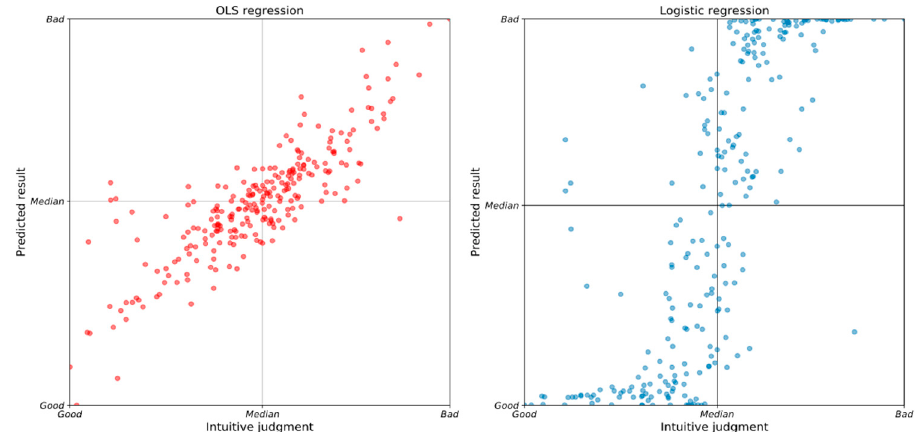
Figure 7. The predicted results were compared with the original data. The horizontal axis presents the original acceleration average level and the vertical axis presents the predicted results in OLS regression ( left ) and logistic regression ( right ) for the whole sample of drivers.